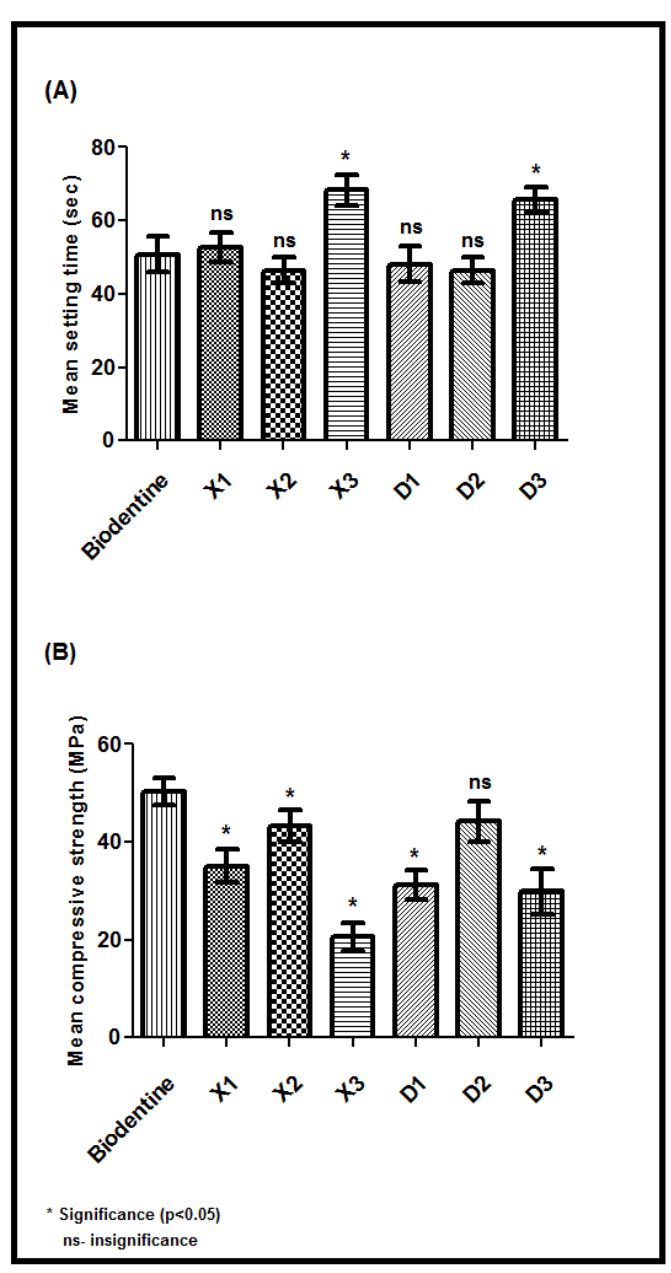
Figure 5. Physiomechanical properties; ( A ) setting time and ( B ) compression strength test. Further, the alkalinity properties of D2 based on timeintervalswere noticed to be comparably equal or less to those of biodentine (Figure